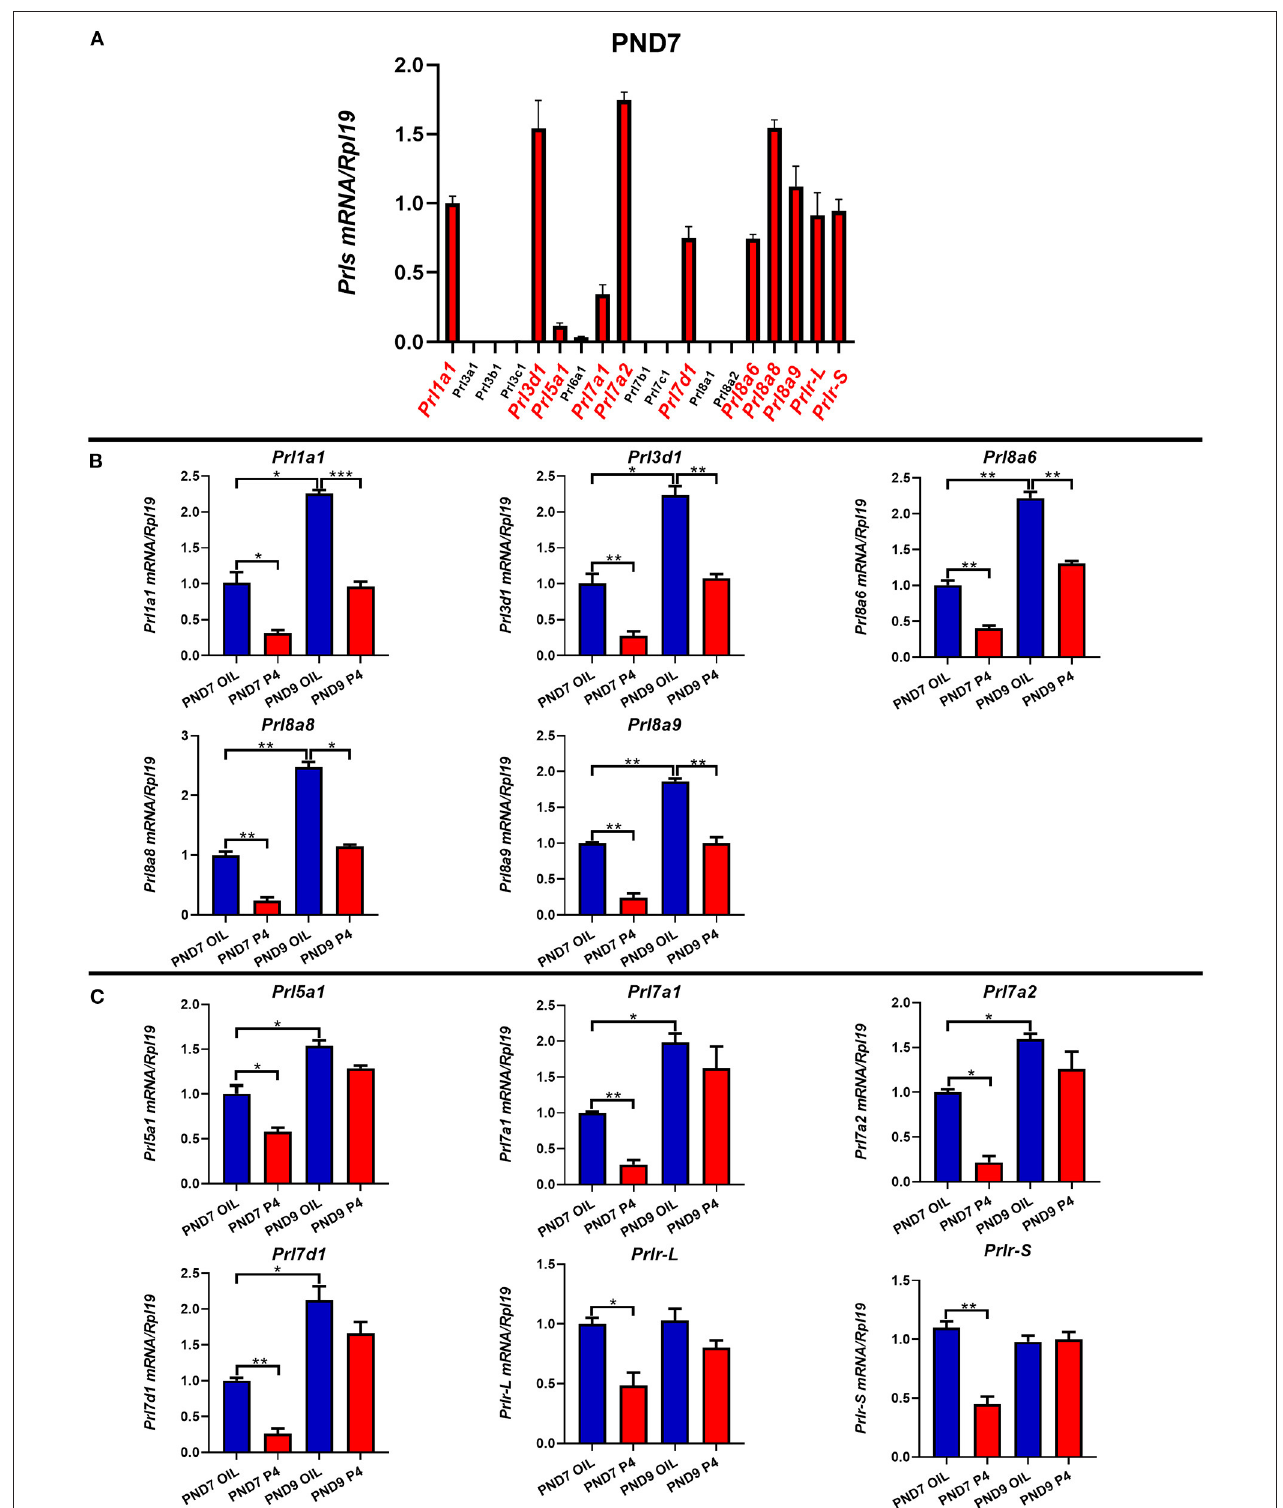
FIGURE 5 | The expression of prolactin family members and prolactin receptor on PND7 and PND9 after treated with P4 or Sesame oil. Comparison of the prolactin family members and the prolactin receptor genes’ expression on PND7 (A) . Prl1a1 , Prl3d1 , Prl8a6 , Prl8a8 , and Prl8a9 genes were suppressed after endometrial adenogenesis inhibited by P4 injection on PND7 and PND9 (B) . The expression of Prl5a1 , Prl7a1 , Prl7a2 , Prl7d1, and Prlr ( Prlr-L and Prlr-S ) were inhibited by P4 injection on PND7 (C) . Results are means ± SEM ( n = 5). Bars with different superscripts are significantly different ( P < 0.05).